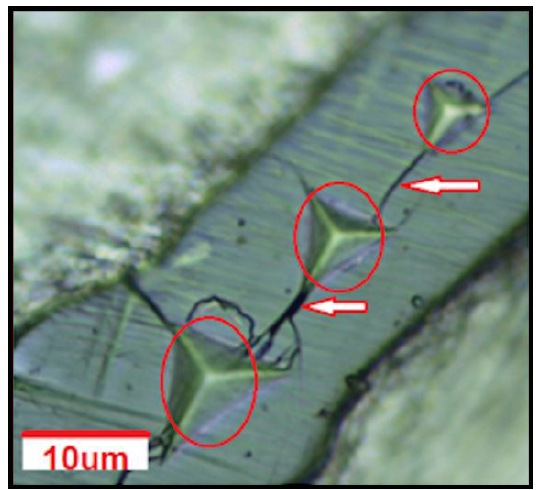
Figure 10. Occurrence of cracks on the Si particle after nanoindentation tests. Sample submitted to solution treatment at 540 o C/6h and ageing at 210 o C/2h.